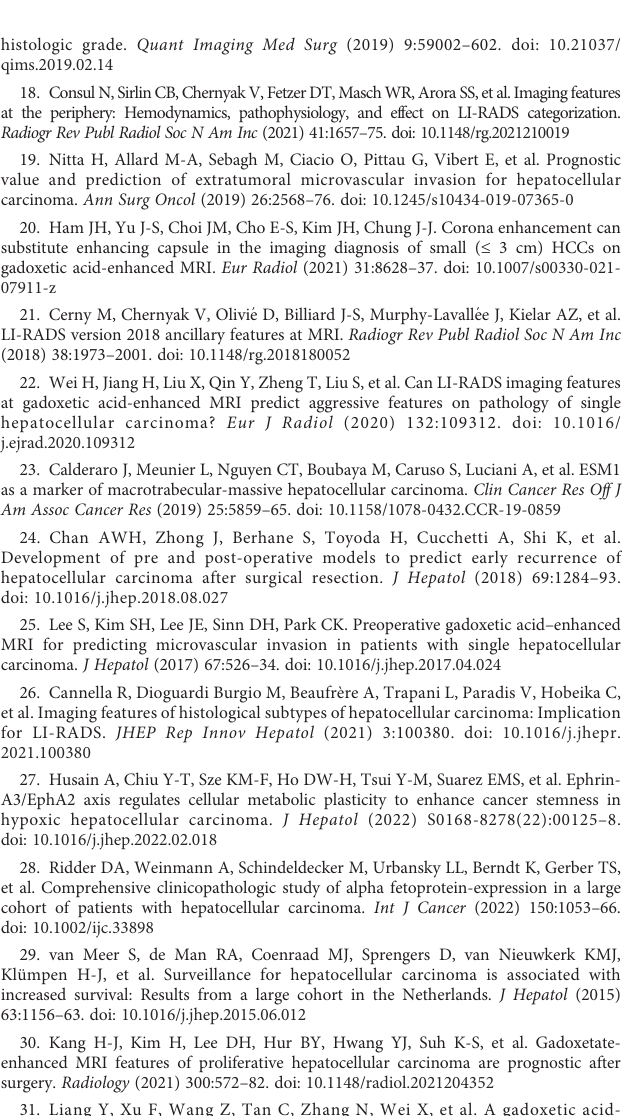
(A); different subgroups of MVI risk